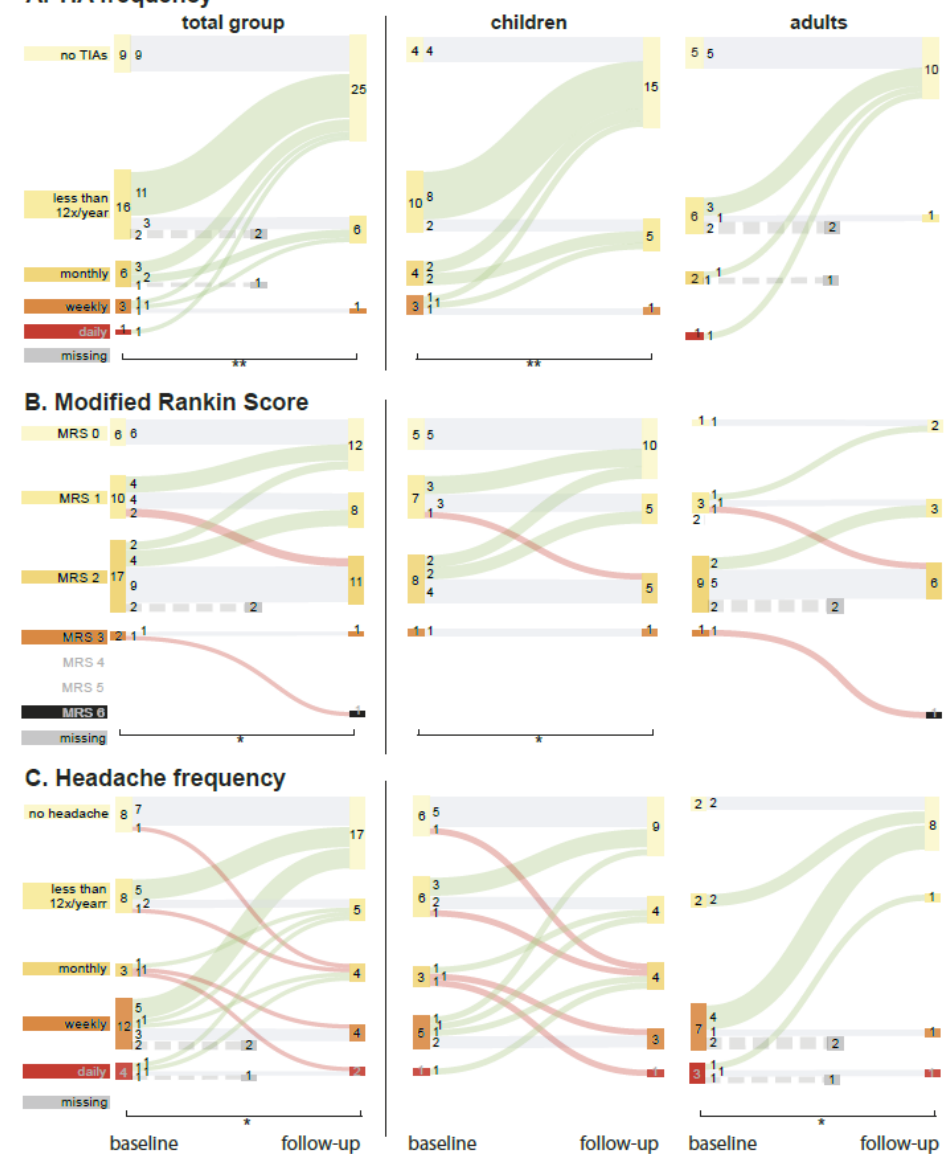
Figure 1. Clinical outcome of treated patients for the total group and for children and adults sepa- rately. The width of the bars represents the number of patients and is described by the value within. Green upward line = improvement; horizontal grey line = stable; downward red line = deterioration. Dotted line represents a patient with missing outcome data. ( A ) Effect of operative treatment on TIA frequency. ( B ) Change in postoperative modified Rankin scale (mRS). ( C ). Headache frequency before and after treatment. Significant differences between baseline and follow-up are denoted with a * ( p -value of <0.05) and ** ( p < 0.005).